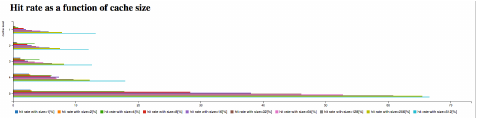
Figure 2: Input data to a workload characterization.